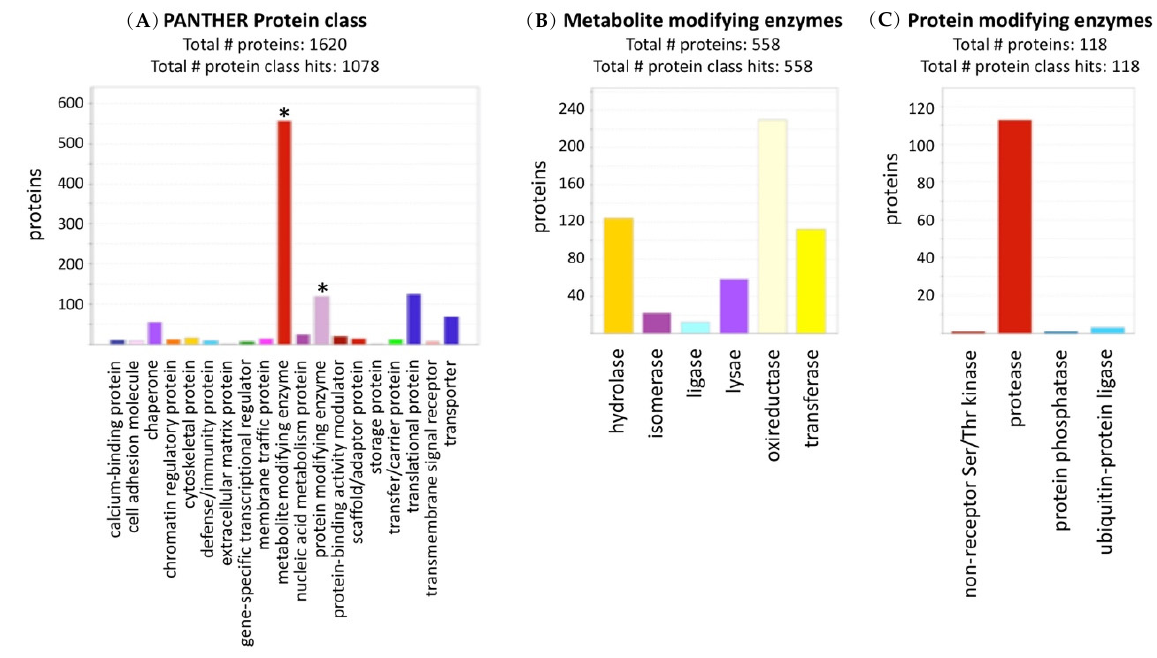
Figure 1. Protein class categorization of proteins accumulated in pericarps derived from treated and untreated plants. ( A ) Protein class categorization highlighting metabolites and protein modifying enzymes among the major groups in this category (asterisks). ( B ) Categorization of metabolite modifying enzymes. ( C ) Categorization of protein modifying enzymes. Note the abundance of proteases in this category. Categorization was performed with PANTHER v.16 [38].